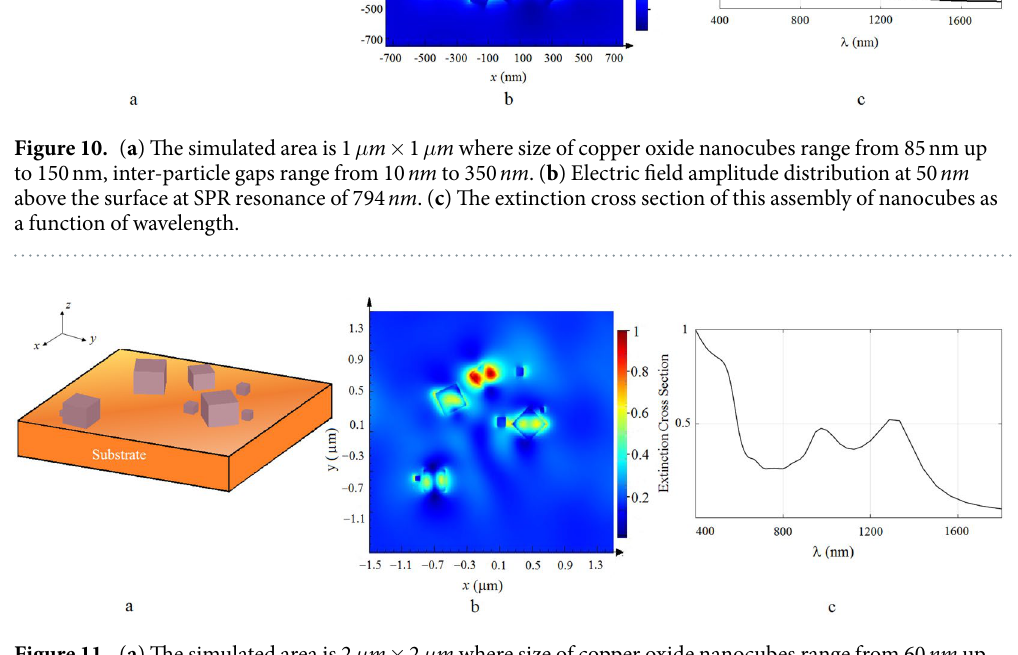
Figure 11. ( a ) The simulated area is 2 μ m × 2 μ m where size of copper oxide nanocubes range from 60 nm up to 300 nm , inter-particle gaps range from 50 nm to 1000 nm . ( b ) Electric field amplitude distribution at 50 nm above the surface at SPR resonance of 971 nm . ( c ) The extinction cross section of this assembly of nanocubes as a function of